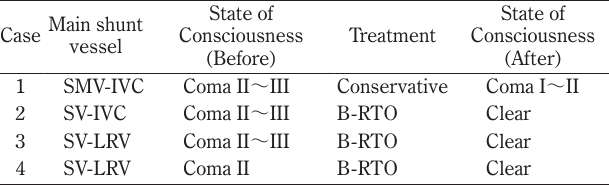
Table 2 Main shunt vessel and changes in consciousness before/ after treatment